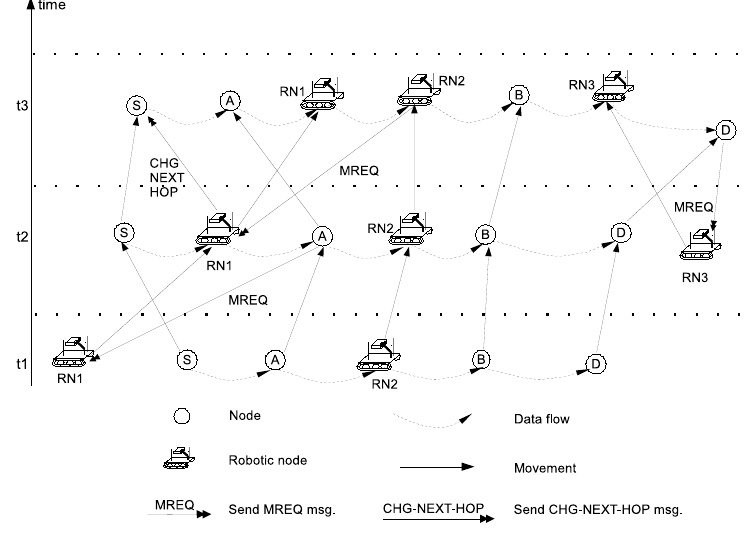
Figure 3. An example of an adaptive link maintenance process over